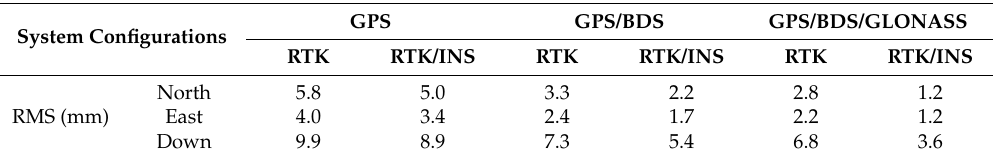
Table 4. RMS of the position difference of RTK and RTK/INS for GPS, GPS/BDS, GPS/BDS/GLONASS at 15 ◦ cut-off elevation